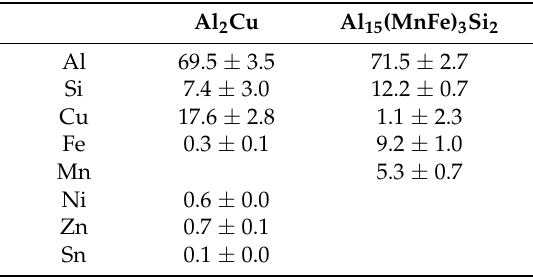
Table 4. Chemical composition (at.%) of different types of phases in the HPDC AlSi 9 Cu 3 Fe alloy (Figure